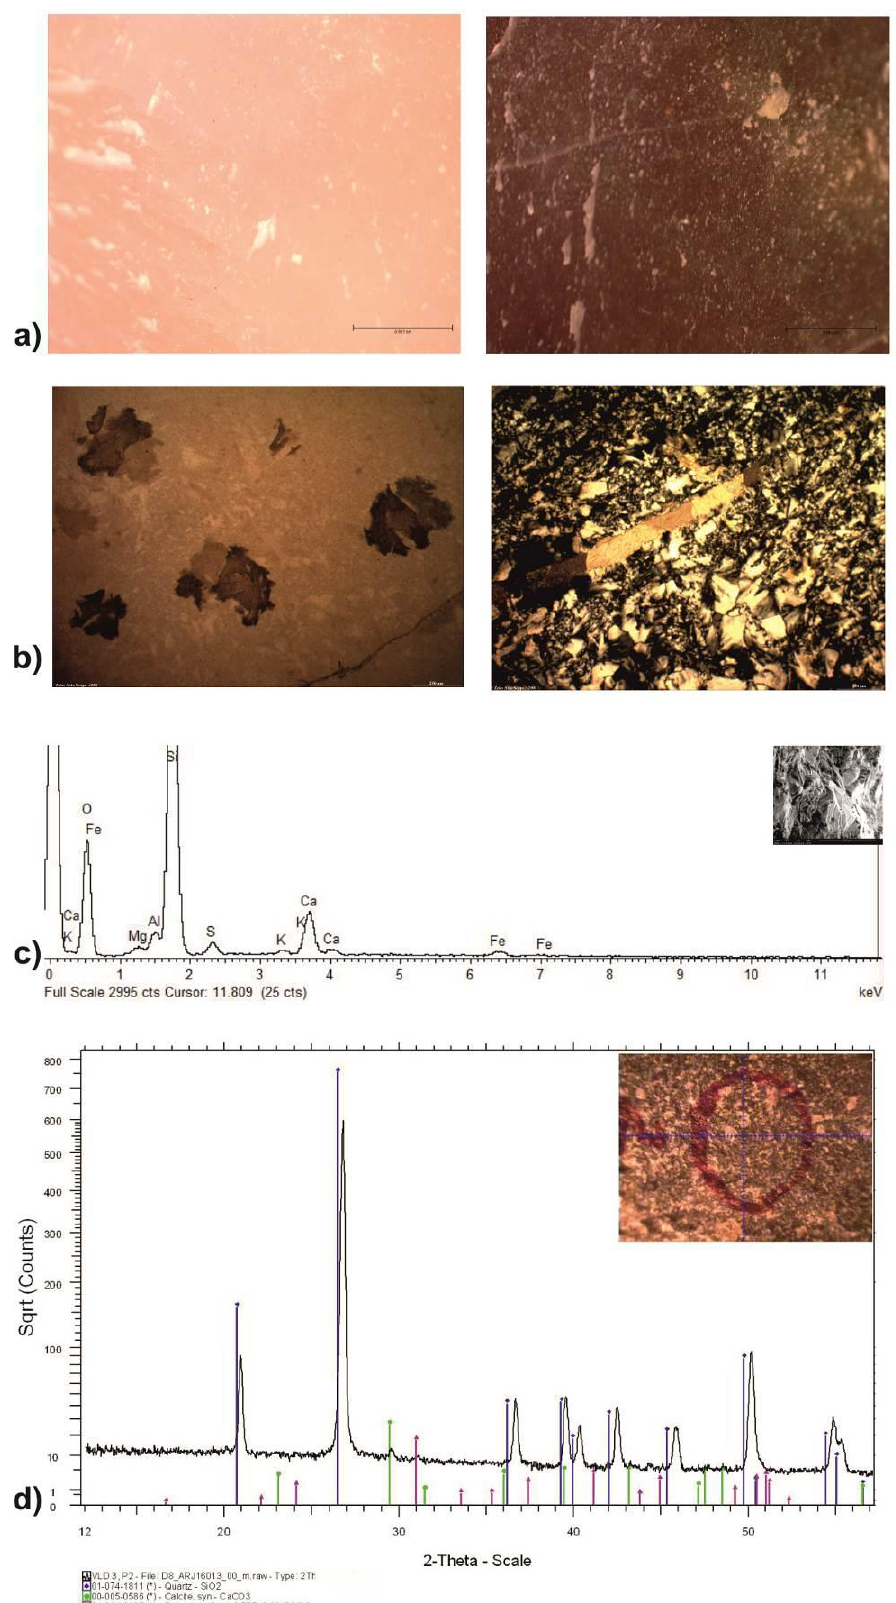
Figure 7. a) Macroscopic aspect of Bartonian cherts. b) Thin section with plane polariser showing carbonates crystals(left) and with crossed polariser showing length-fast chalcedony and carbonates filling fissures. c) ESEM chemical component Spectrum. d) μ-XRD of the indicated